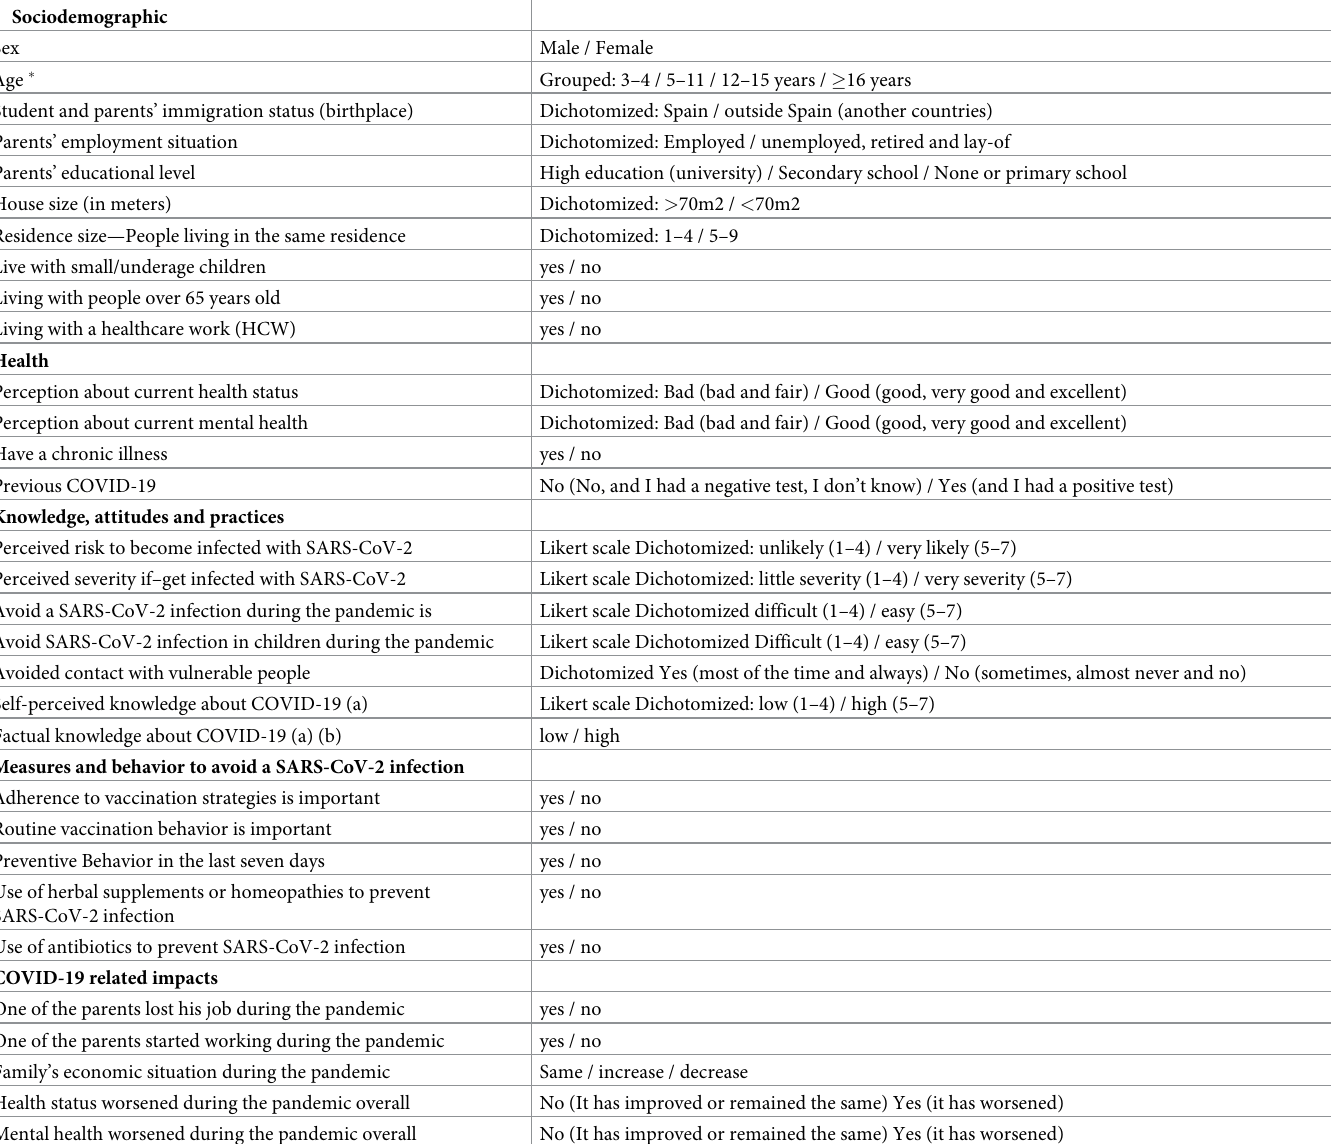
Table 1. Independent variables included in the study, CSSNC Catalonia, Spain